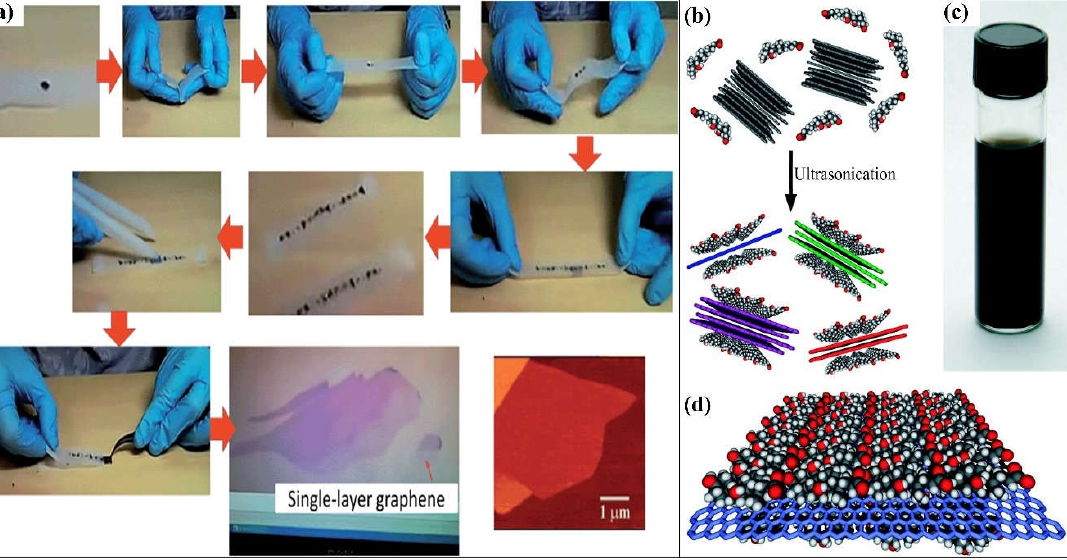
Figure 3. Schematic illustration of graphene synthesis methods: ( a ) Scotch tape method to produce single-layer graphene via the cleavage of HOPG sample. Adapted with permission from [28]. Copyright RSC 2015. ( b ) Schematic illustration of the exfoliation process of graphene via the ultrasonication of graphite flakes with sodium cholate (SC). ( c ) Optical image of six-week dispersion in SC. ( d ) Schematic illustration of the ordered SC monolayer on graphene. Adapted with permission from [29]. Copyright ACS 2009.